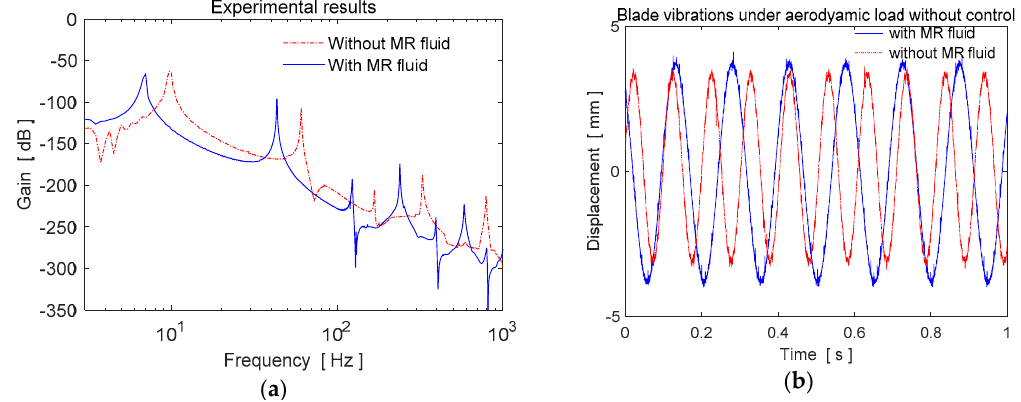
Figure 3. Experimental results of the empty and MR fluid filled blade without magnetic field ( a ) frequency responses, ( b ) time responses.